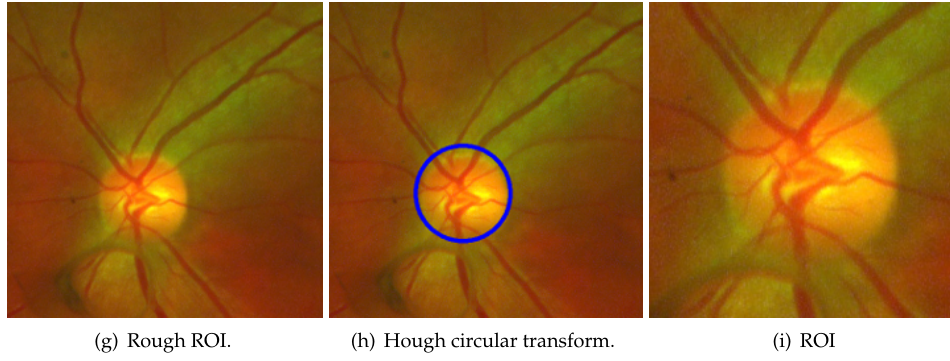
Figure 10. Results of each process of ROI detection in wide-angle fundus images.